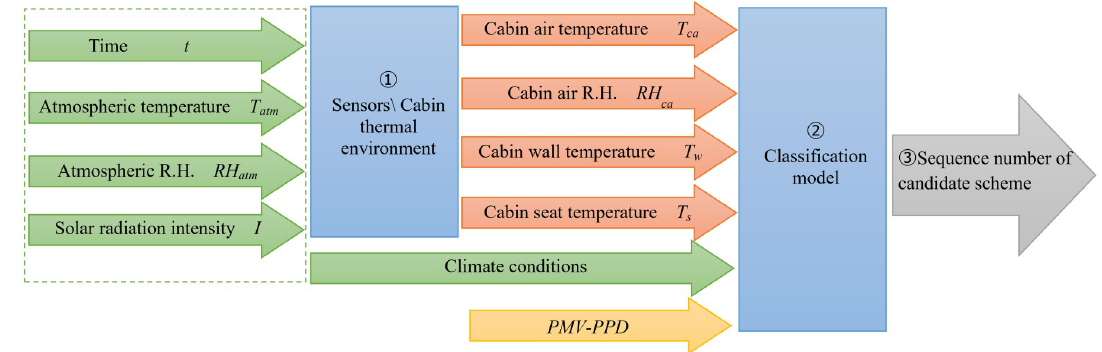
Fig 3. The data flow within the data-driven decision model. A classification model identifies and matches schemes based on the cabin temperature and humidity, seat and wall temperature and climate conditions.